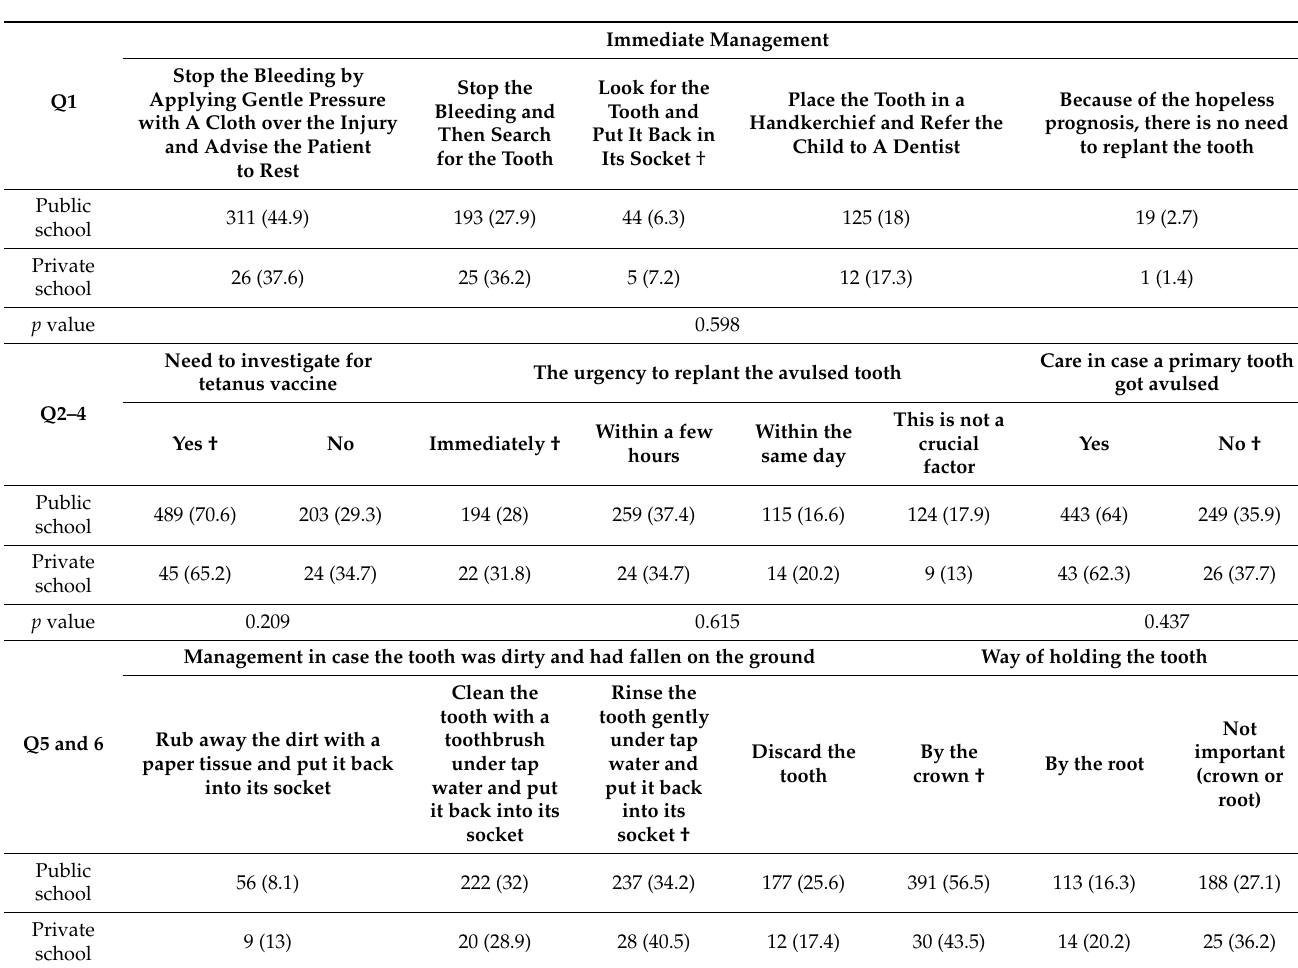
Table 3. The frequency and percentage, N(%) of medical students’ responses to the first six questions of the second case scenario according to the school